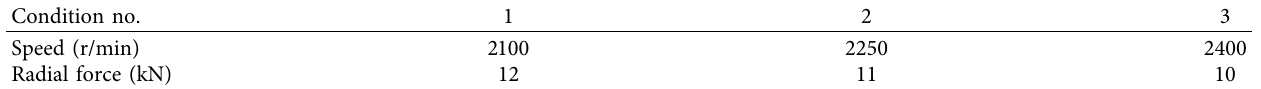
Table 1: Bearing operating conditions.